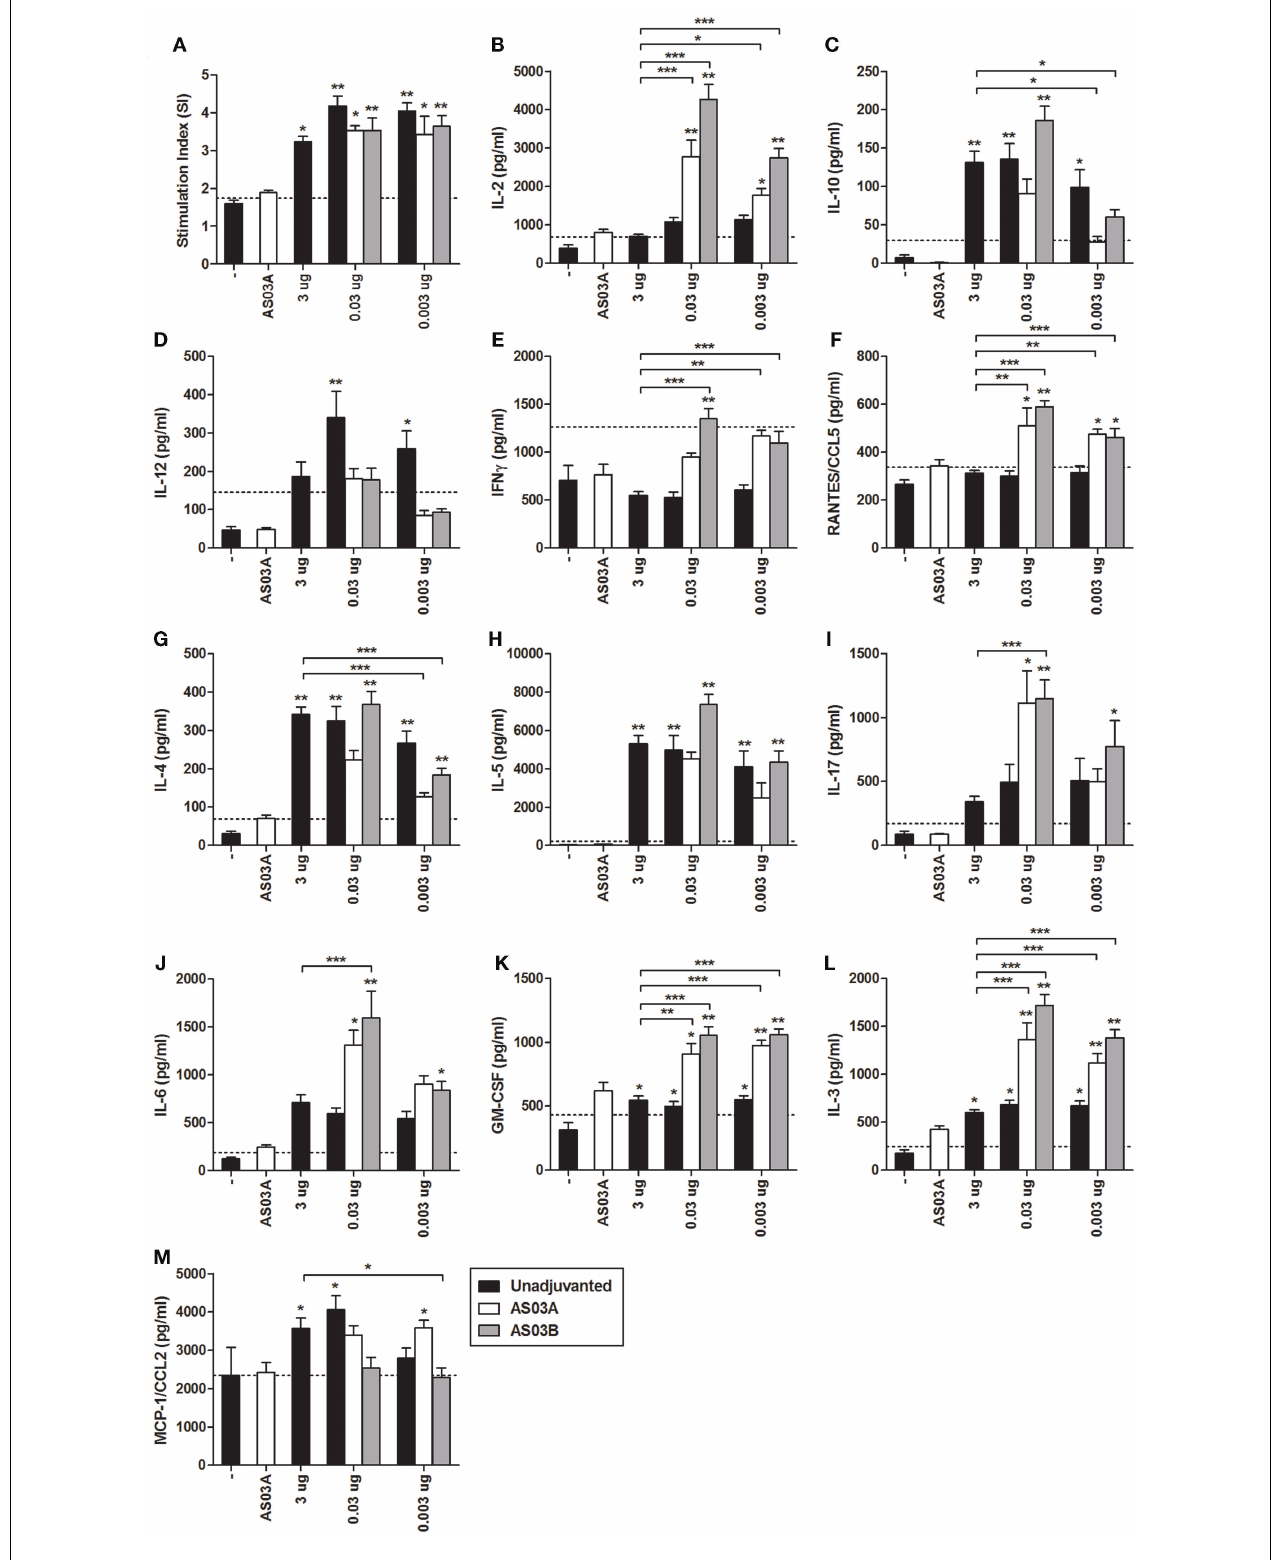
dose-sparing vaccines . BALB/c mice were immunized intramuscularly on days 0 and 21, and splenocytes were isolated from individual mice on day 42.